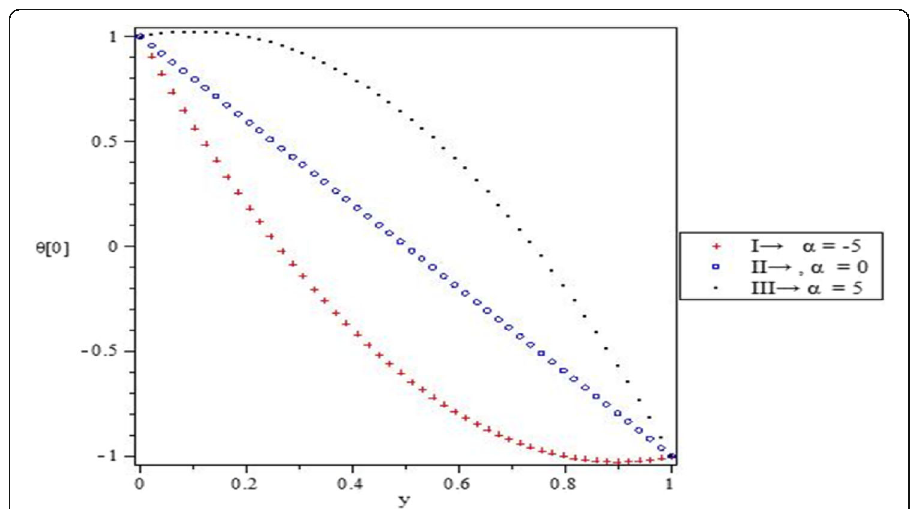
Fig. 8 Zeroth-order temperature ( θ [0] profile, r = − 1, and β =